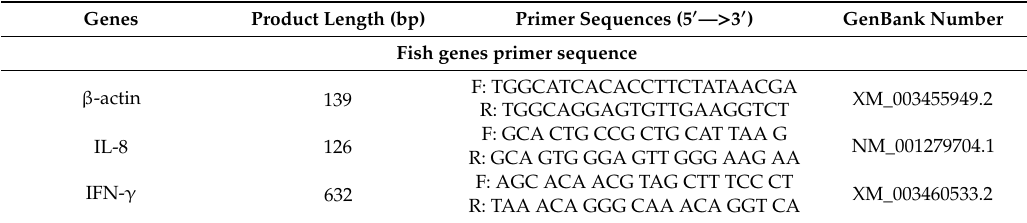
Table 2. Primer sequences used for real time PCR